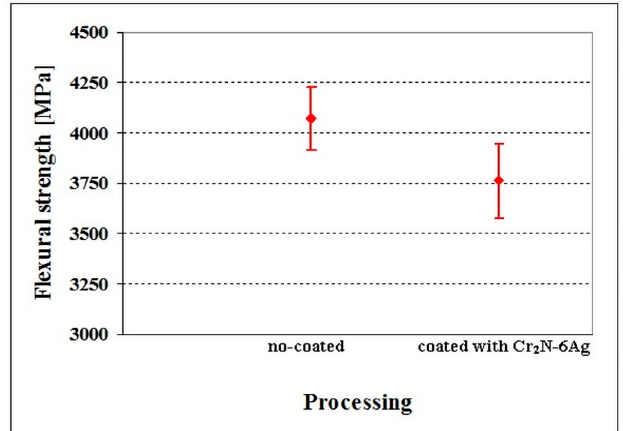
Figure 14. Flexural strength of no-coated and Cr 2 N–6Ag-coated Vanadis 6 steel. The values of flexural strength are adapted from the corresponding literature [59].